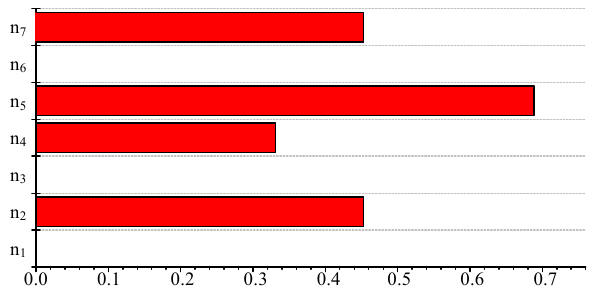
Figure 25. Correlation of 7 optimization parameters to maximum deformation sensitivity.